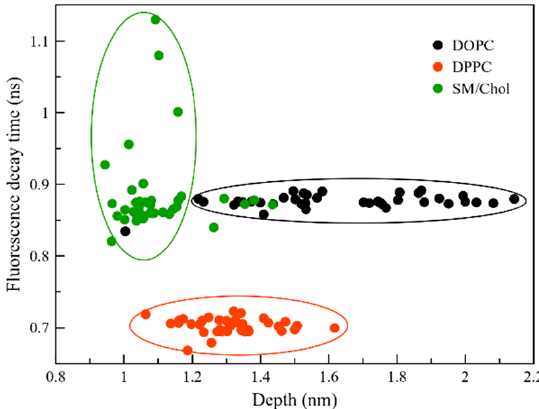
Figure 6. Correlation between location of the DPH probe in the membrane and the fluorescence decay time. The depth is defined as the difference between the phosphorous atoms at the membrane surface and the center of mass of DPH.